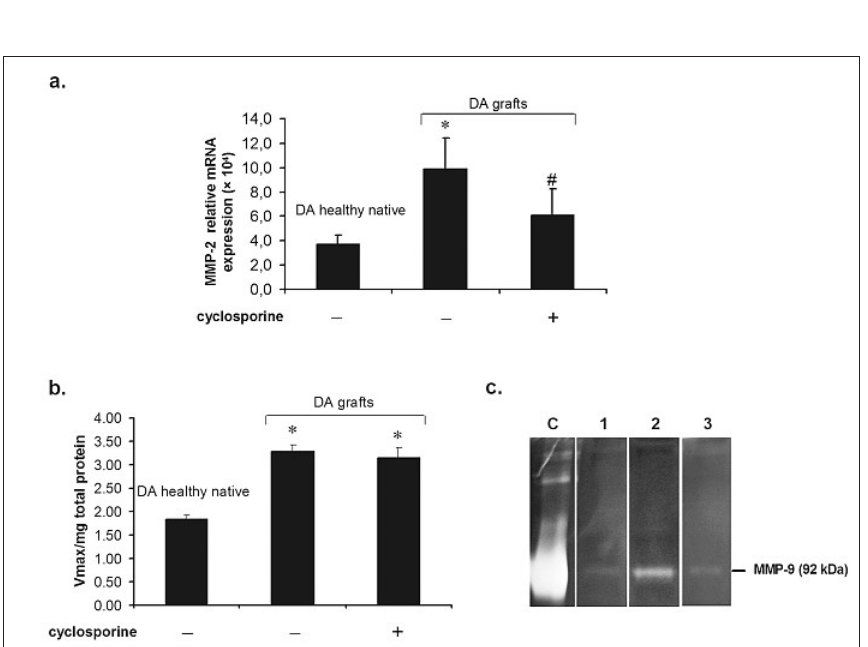
Hierarchical cluster analysis of gene expression profiles from rat hearts. 1 = DA healthy native hearts, 2 = Untreated DA cardiac allografts (AR), 3 = CsA treated DA cardiac allografts. Each column represents a sample; each row represents a gene from the gene list of Supple- mentaryTable.Transcripts abundance is dis- played on a red-green colour scale, with red expression above and green expression below the median.The cluster dendrogram sorts the samples based on the degree of similarity of gene expression profiles. Based on our genes of interest, rat samples with untreated AR can be clearly separated from the control and CsA- treated groups.